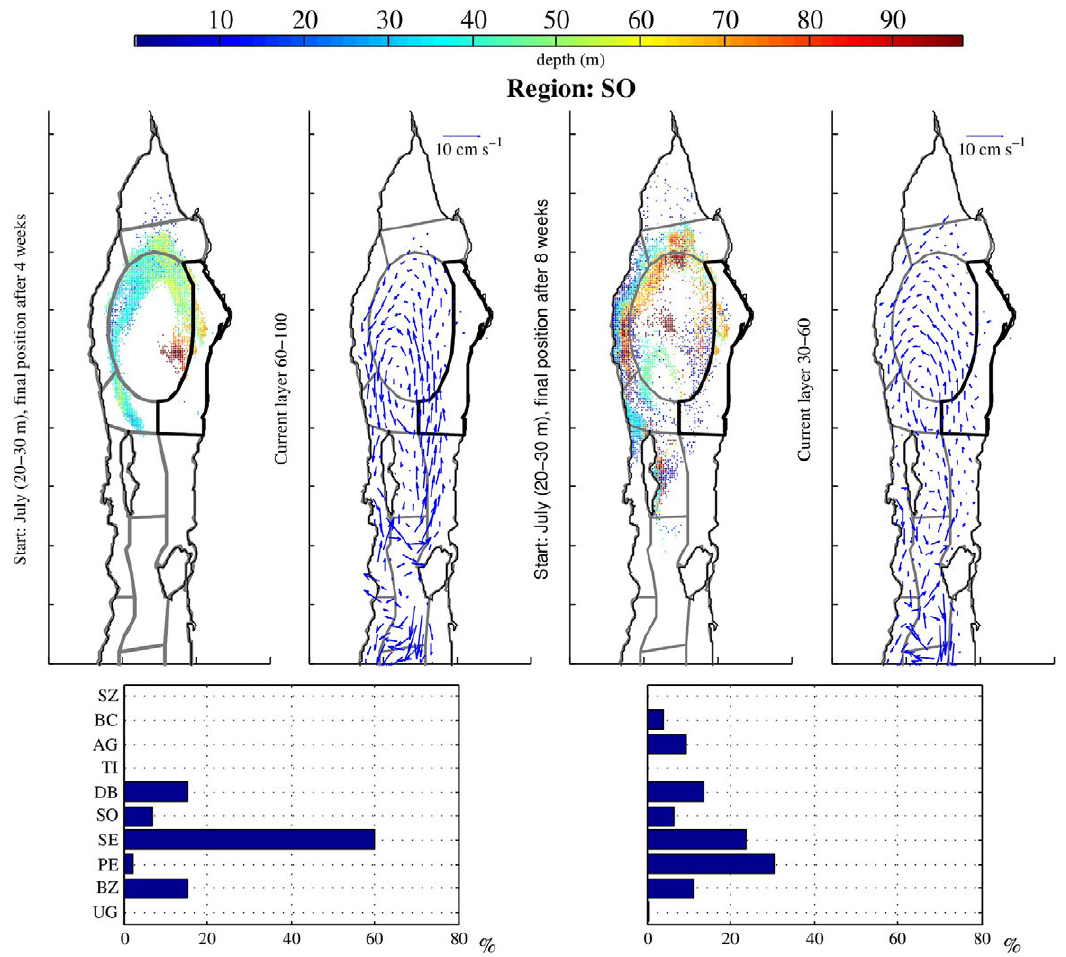
Fig. 7. – Map of final positions of particles released in the northern coast of Sonora’s second layer, in the fourth and eighth week after the release of particles. The release area is shown in black and the other areas in grey polygon. The colour bar represents the depth at which each particle is located. The histogram shows the percentage of particles retained or transferred to other regions. Current maps correspond to the layer in which the percentage of particles retained is concentrated, in the fourth and eighth week after particle